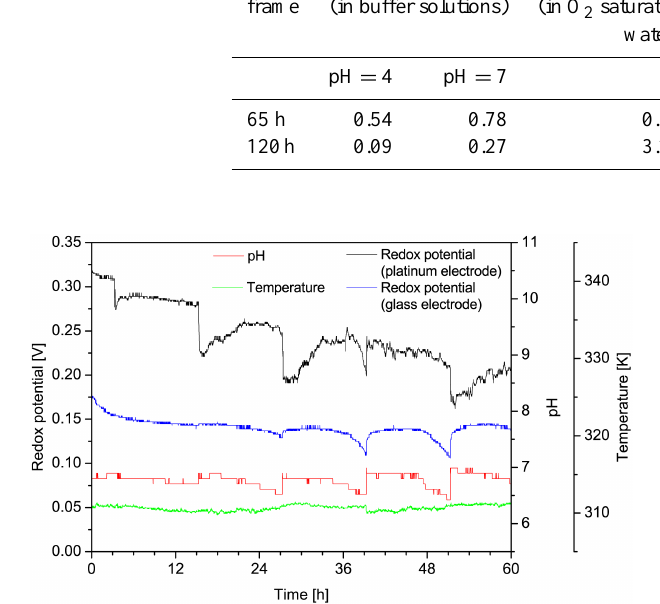
Figure 5. Influence of the air cleaning and the inlet stops (every 6h) on the parameters redox potential, oxygen content and temperature during a measurement in the process water of a paper